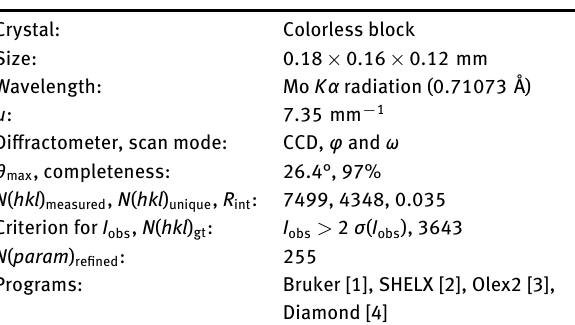
Table 1: Data collection and handling.